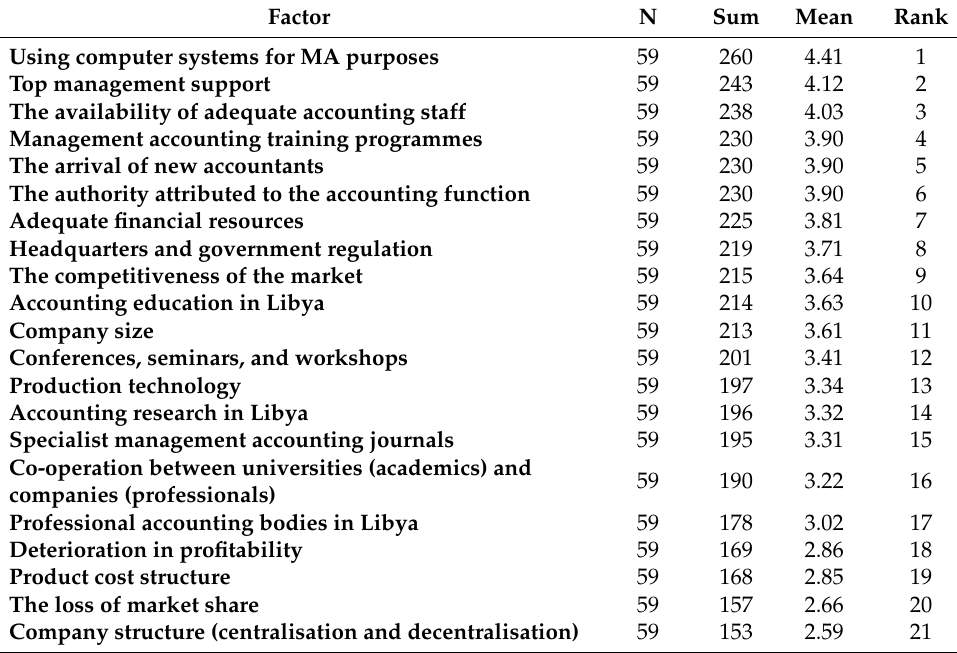
Table 11. Contextual factors and the adoption of MAIs in the non-manufacturing sector.